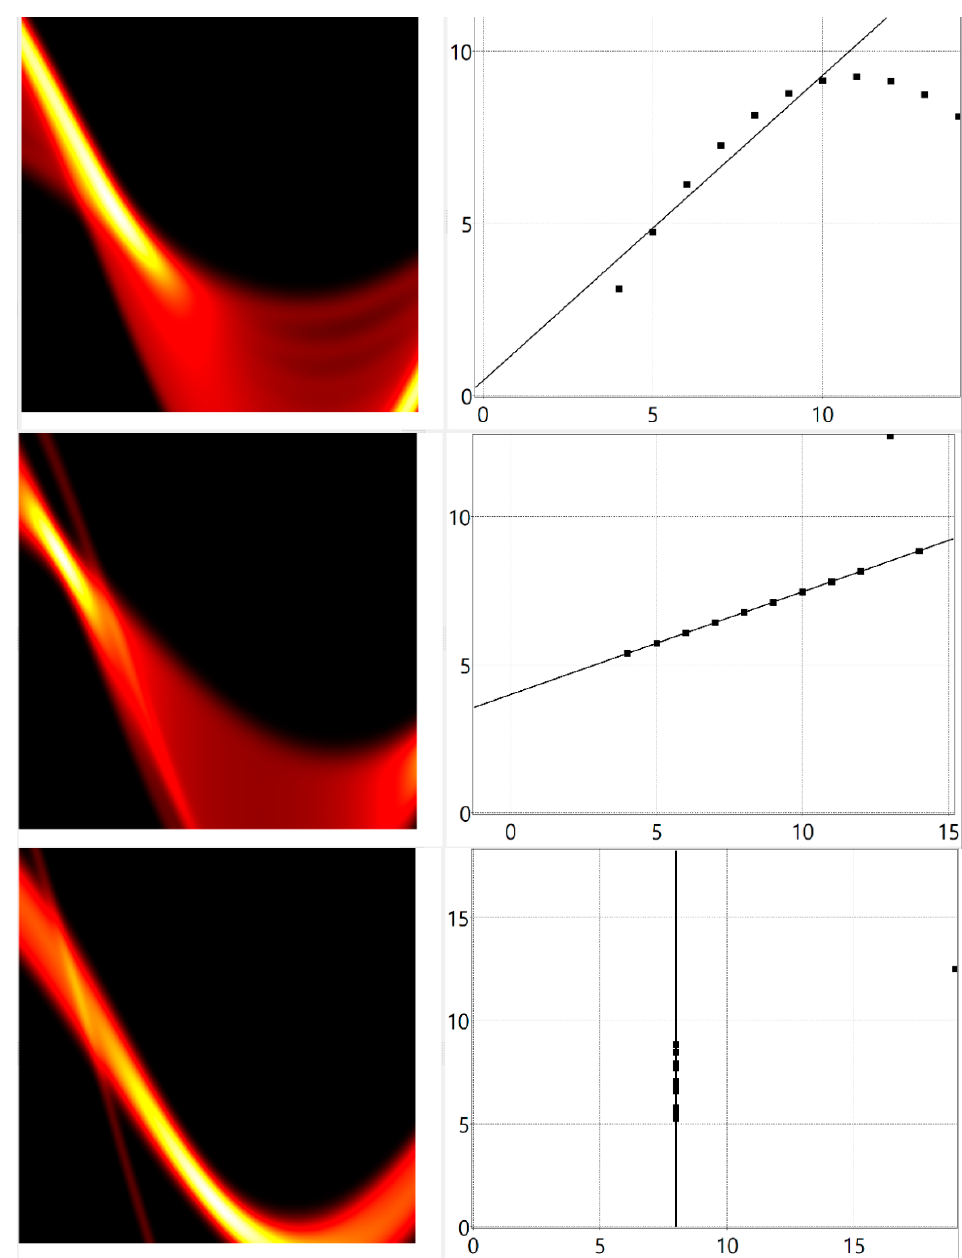
Figure 2. Results of the analysis of the data presented in the Anscombe quartet ( σ = 1).